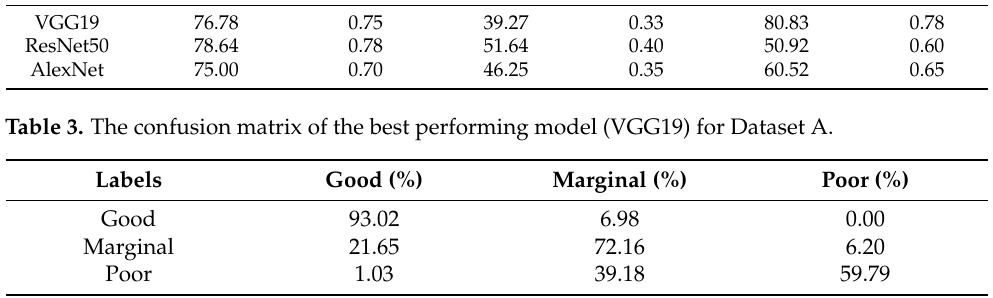
Table 4. The confusion matrix of the best performing model (VGG19) for Dataset C.